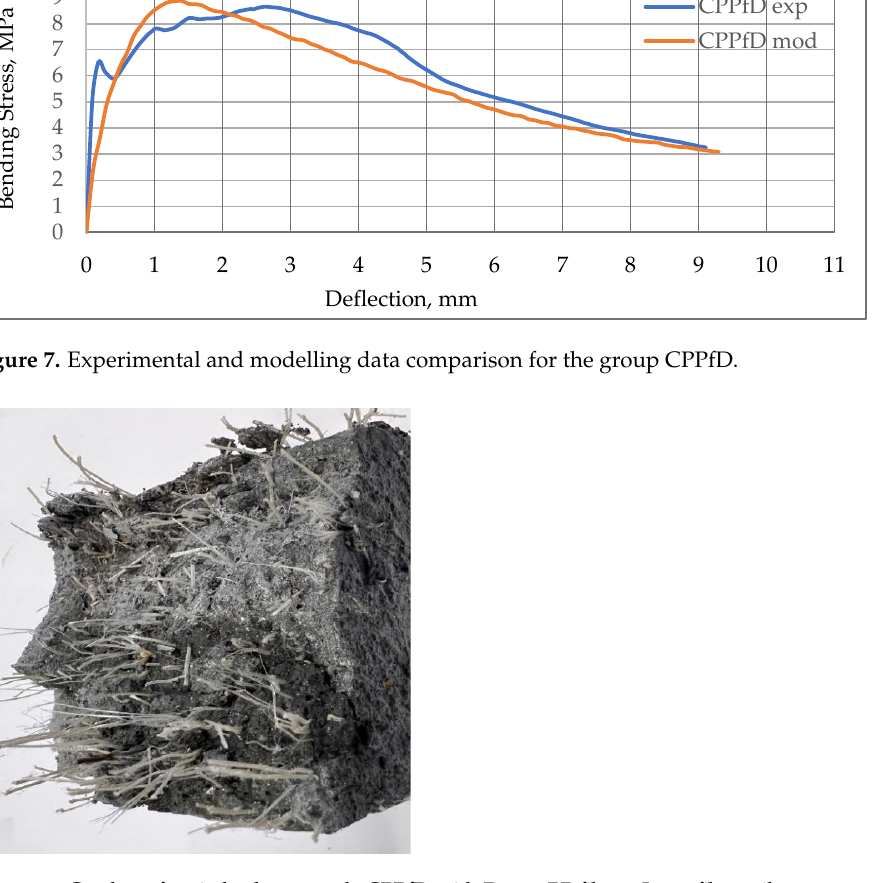
( b ) Figure 9. Back analysis. Pull-out curve for single Durus PP fiber: ( a ) pull-out curve at the stage till the first peak; ( b ) whole curve. 5. Conclusions Based on the results presented and discussed in the paper, the following conclusions have been drawn: 1.